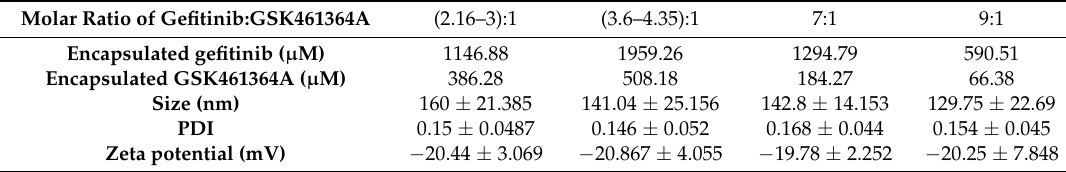
Table 3. Characterization features of engineered NPs using ratiometric control.